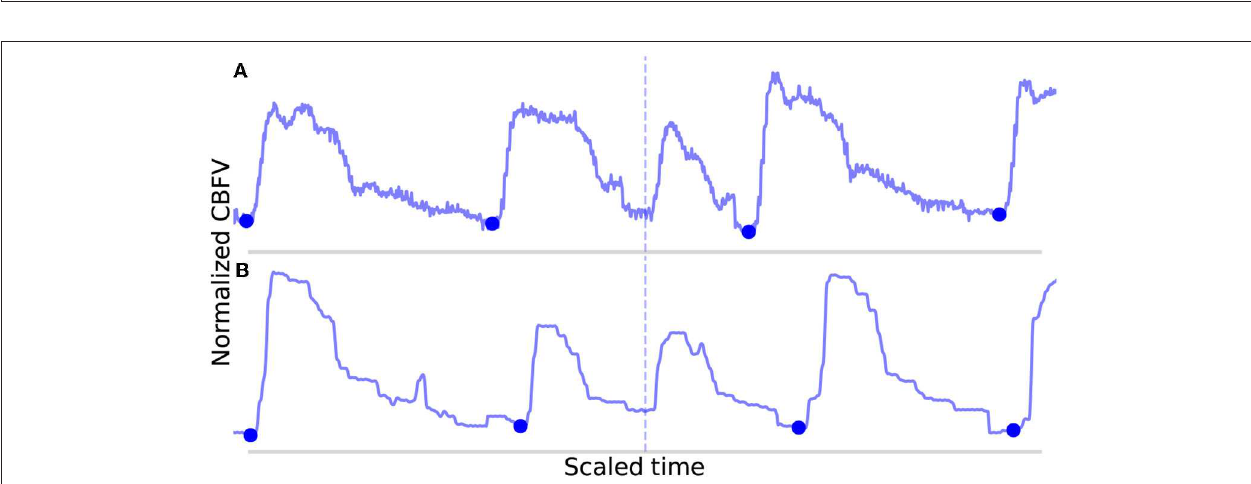
FIGURE 8 | Shown in (A,B) are the false negatives detected by the algorithm in the data set. The correctly identified manually annotated beat onsets are marked by filled-in blue dots. The locations in which an annotated onset was indicated but no onset detected are marked by the dotted